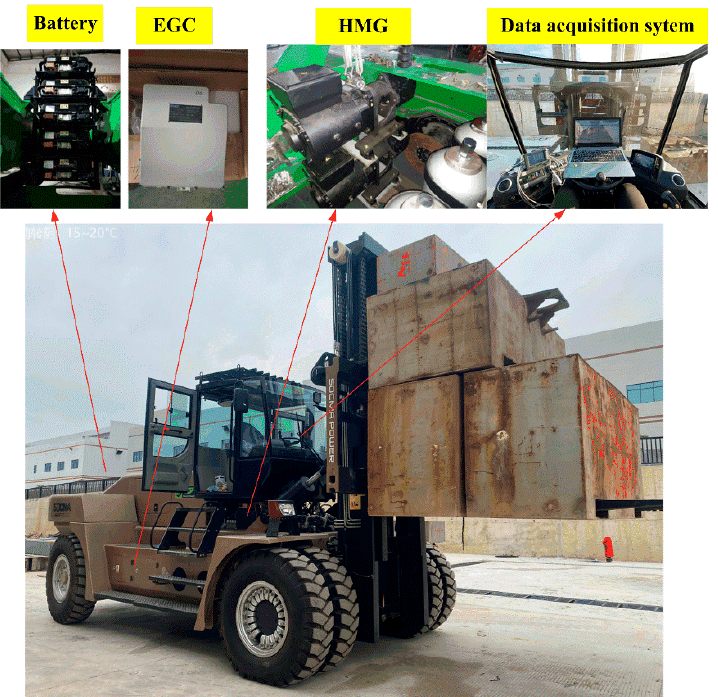
Figure 8. Prototype EHF and its key components for the test. Table 2. Parameters of the key component.